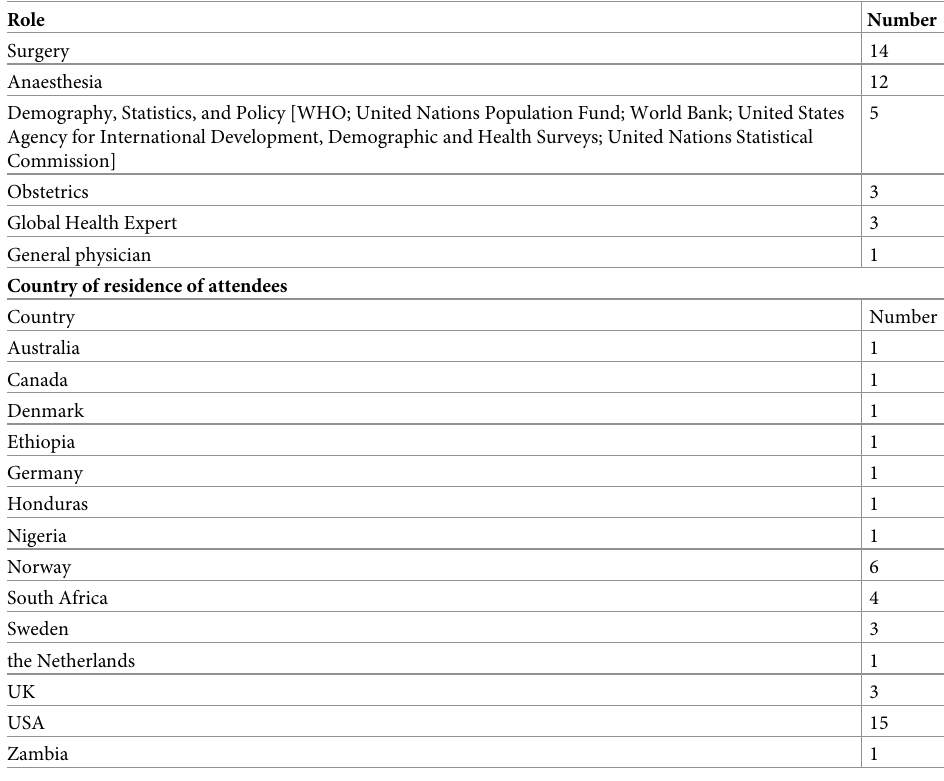
Table 2. Country of origin and specialty of meeting attendees. Note that 2 of the attendees work in multiple settings, EM in Zambia and South Africa, and JD in the UK and South Africa; hence, numbers do not add up to 38.